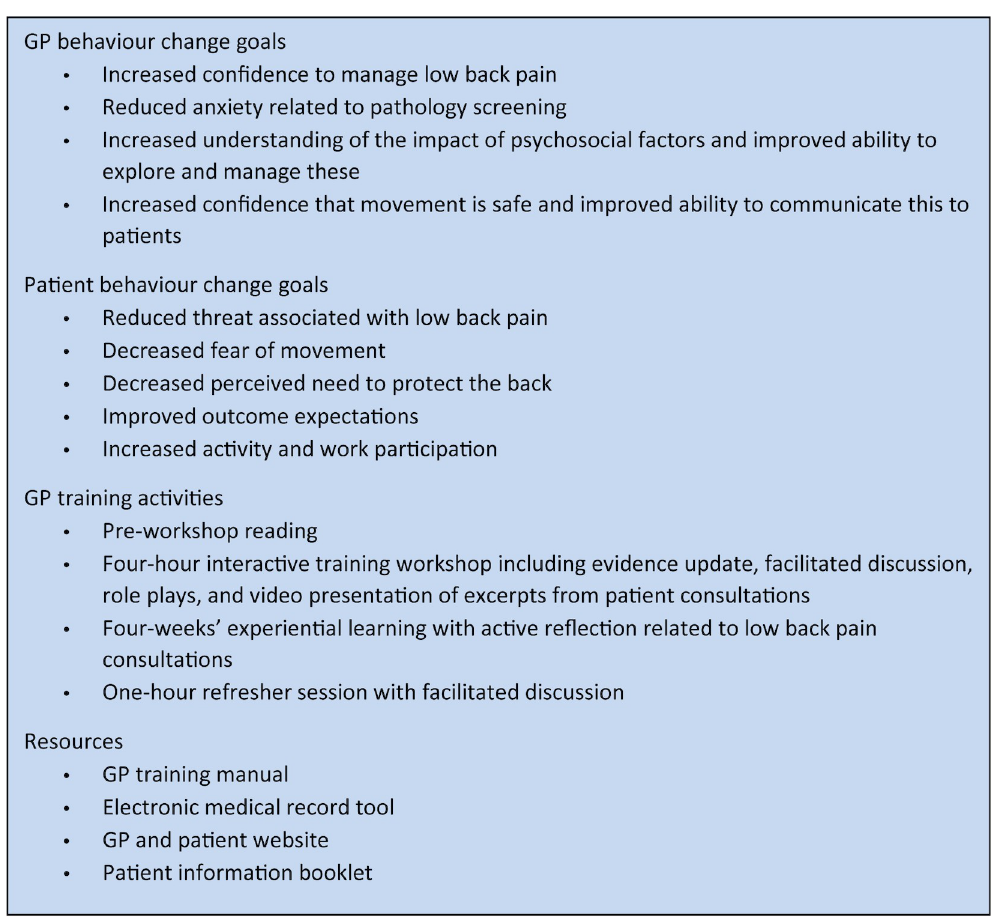
Fig 1. Overview of the FREE approach to LBP. FREE, Fear Reduction Exercised Early; GP, general practitioner; LBP, low back pain.